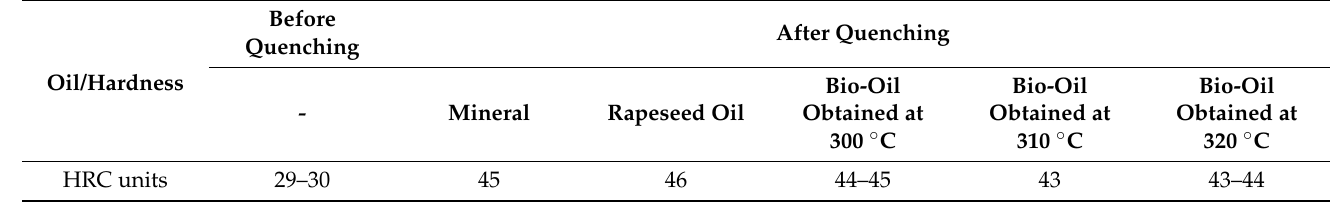
Table 4. Hardness of stainless steel 25CD4 bars before and after quenching in different oils. After Before After Quenching Quenching Oil/Har dness Rapeseed - Mineral oil HRC